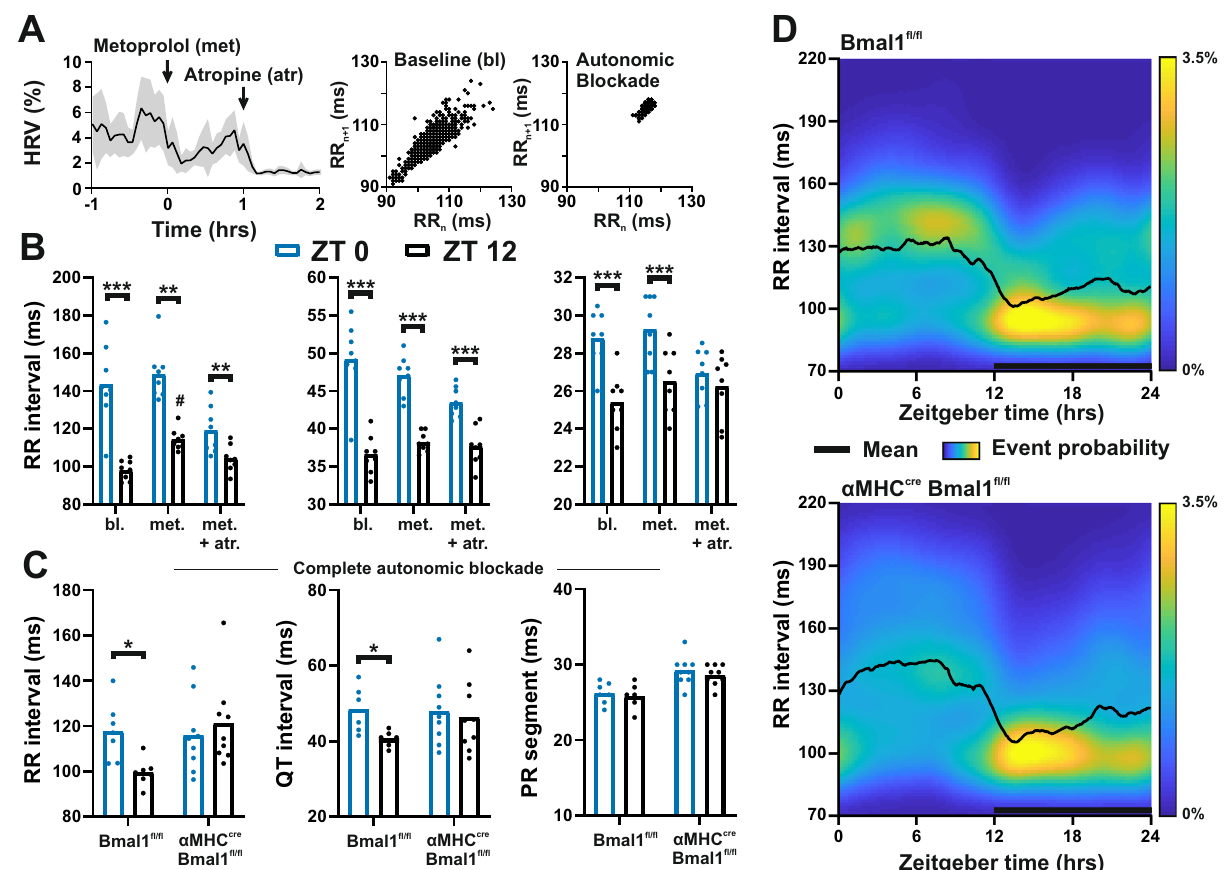
Fig. 4 Relative contribution of autonomic nervous system input and local cardiac clock in setting RR and PR seg in mice. A Heart rate variability (HRV) during autonomic blockade (with metoprolol and atropine) in conscious free-moving mice (left panel: a geometric measure of HRV, shaded region represents + / − SEM, right panels: Poincaré plots pre-blockade (baseline, bl) and under complete block). B Complete autonomic blockade (met + atr) reduced, but did not remove, time-of-day-dependent differences in RR or QT intervals (blue: ZT0; black: ZT12; n = 8 mice). In contrast, no time-of-day difference was observed in PR seg under complete autonomic blockade (two-way RM ANOVA, Sidak ’ s post hoc). C In contrast to Bmal1 Fl/Fl control mice, no time-of- day differences in RR or QT intervals were evident in α MHC CRE Bmal1 Fl/Fl mice following complete autonomic blockade ( n = 7 Bmal Fl/Fl , 9 aMHC cre Bmal Fl/Fl ; two-way RM ANOVA, Sidak ’ s post hoc). D Twenty-four hours distribution of RR intervals in control ( Bmal1 Fl/Fl ; top) and littermate cardiomyocyte-speci fi c Bmal1 knockout mice ( α MHC CRE Bmal1 Fl/Fl ; bottom). Heatmap shows the occurrence of RR interval distribution across 5 days of recording; black line re fl ects group mean. Substantial RR interval lengthening and variability were evident in the day and late-night. All data presented as mean ± SEM. * P < 0.05, ** P < 0.01, *** P < 0.001 between time, # P < 0.05 between treatment. See Supplementary Fig. S8 for additional information related to this fi gure. Source data and statistical details are provided as a Source Data